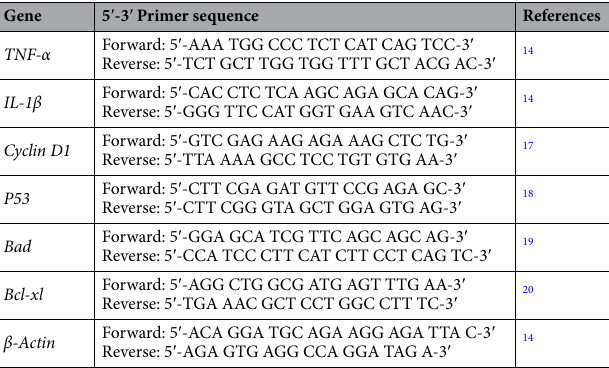
Table 1. Primer lists for the real-time polymerase chain reaction.